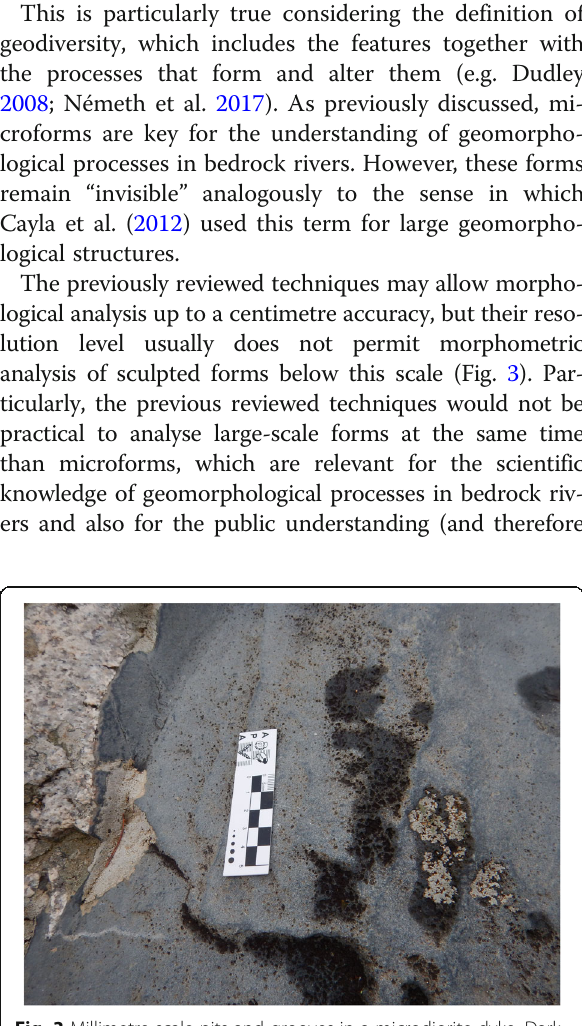
Fig. 3 Millimetre-scale pits and grooves in a microdiorite dyke. Dark- coloured area corresponds to moisture accumulated in and around pits. This is likely to cause weathering through wetting-drying